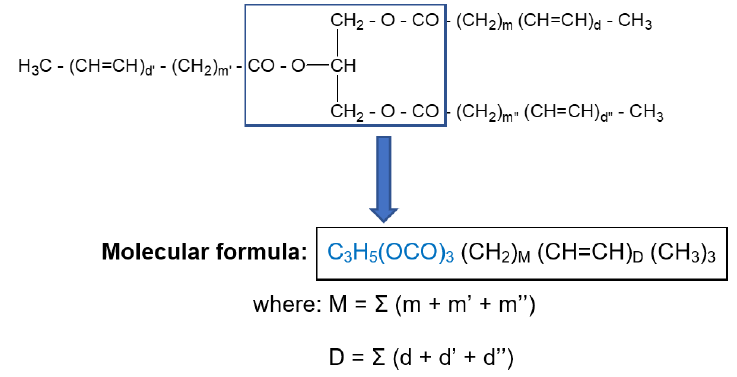
Figure 2. General representation of a triacylglycerol structure .